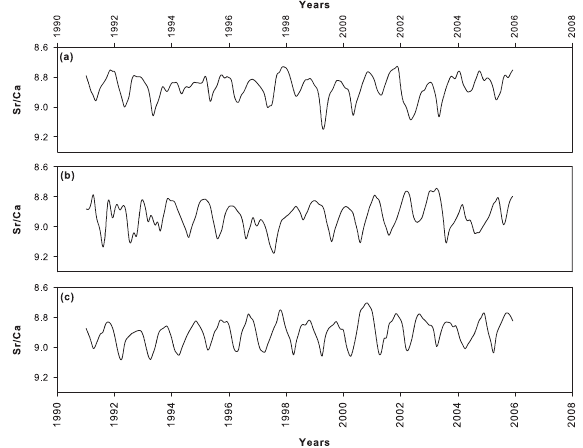
Fig. A1. The Sr/Ca time-series of coral cores MAS1 (a) , ANDRA (b) and IFAHO (c) for the common period 1991–2005. Fig. A02